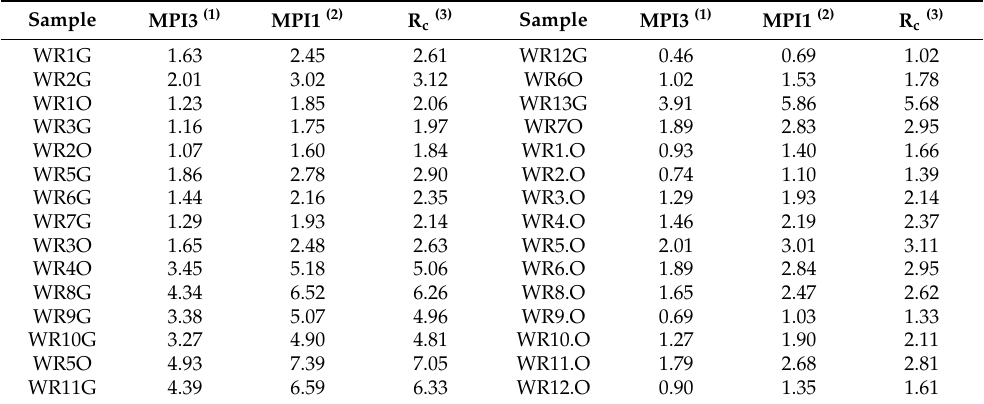
Table 4. Values of geochemical ratios found in DEP extracts ratios in the Trzebinia samples. Sample